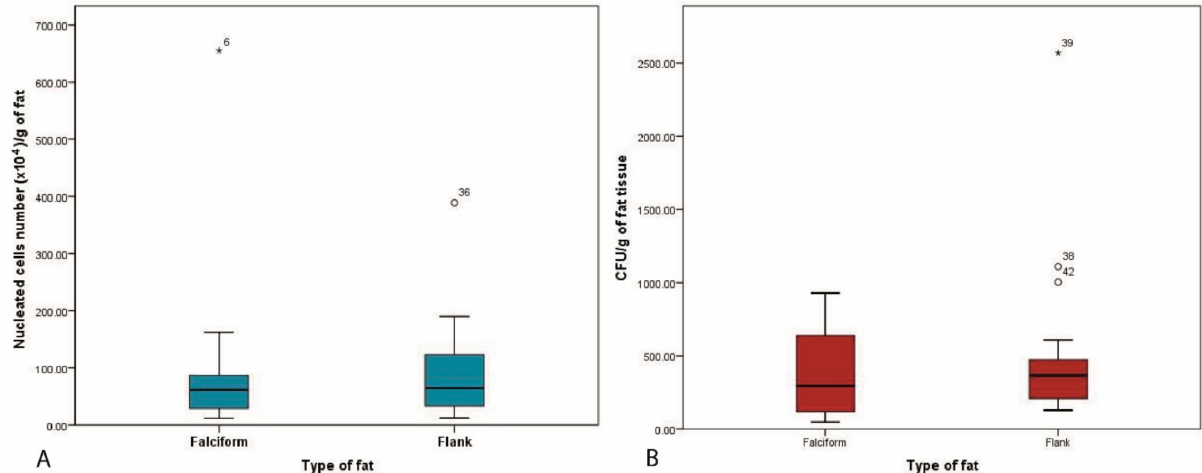
Figure 3. The SVFs and CFU per gram of fat from the two anatomical regions. There was no significant difference in the number of nucleated cells ( p = 0.602) ( A ) or CFU/g of fat ( p = 0.312) ( B ) harvested from the falciform or the flank